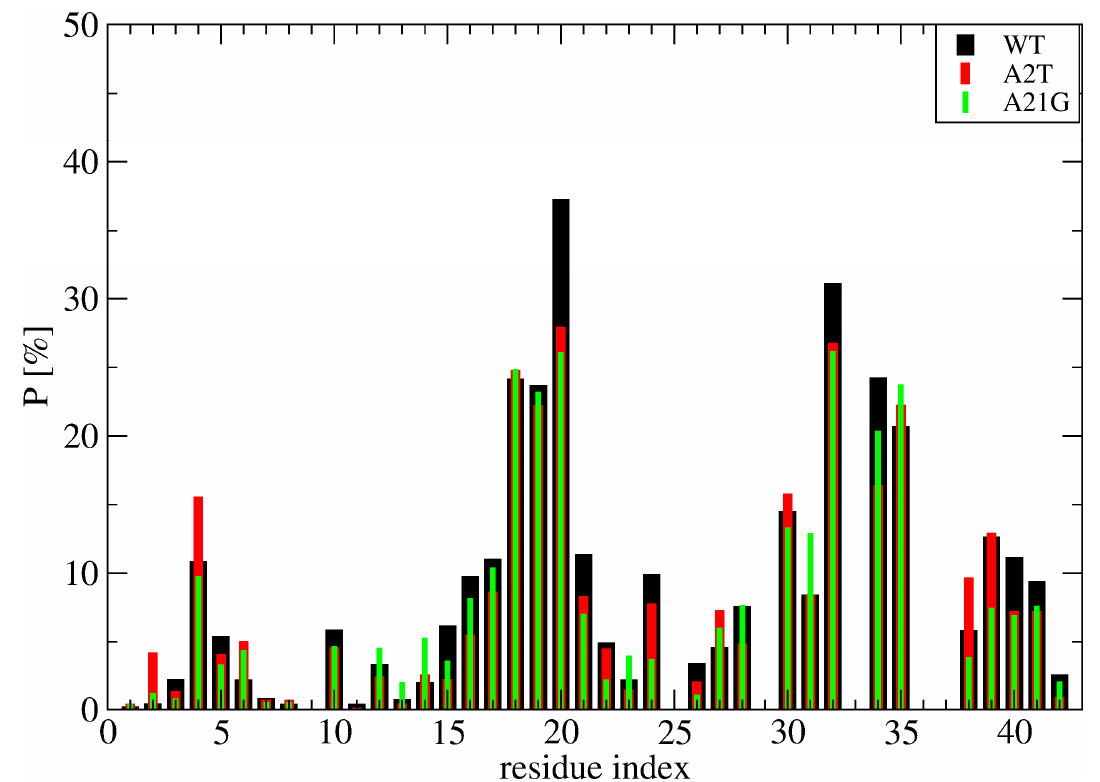
Figure 9. Time-averaged probability of contacts between the cholesterol molecules and the side-chain of A β 42 obtained from 1 microsecond MD trajectory at 310 K of the wild-type (WT, black), A2T mutation (red) and A21G mutation (green) sequence. Shown are the averaged values over the three simulations starting from the S1, S2 and S4 structures displayed in Figure 7.